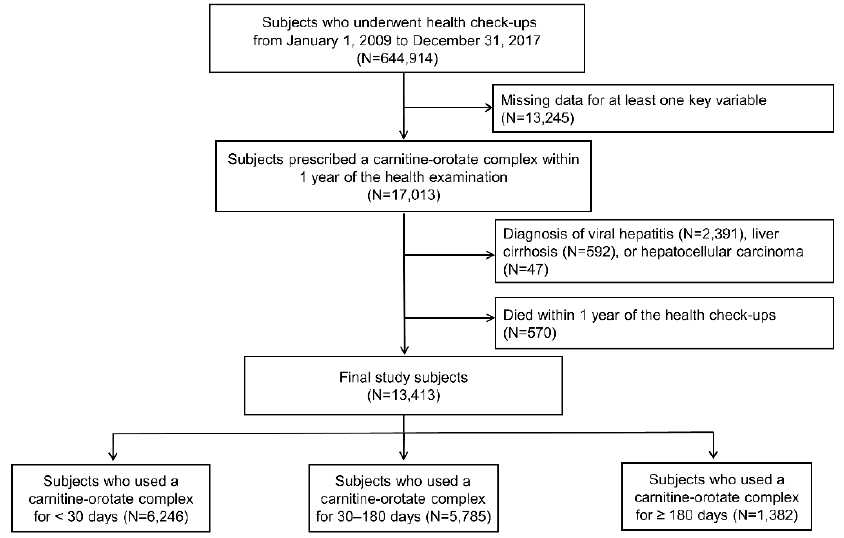
Figure 1. Flow chart of the study population.